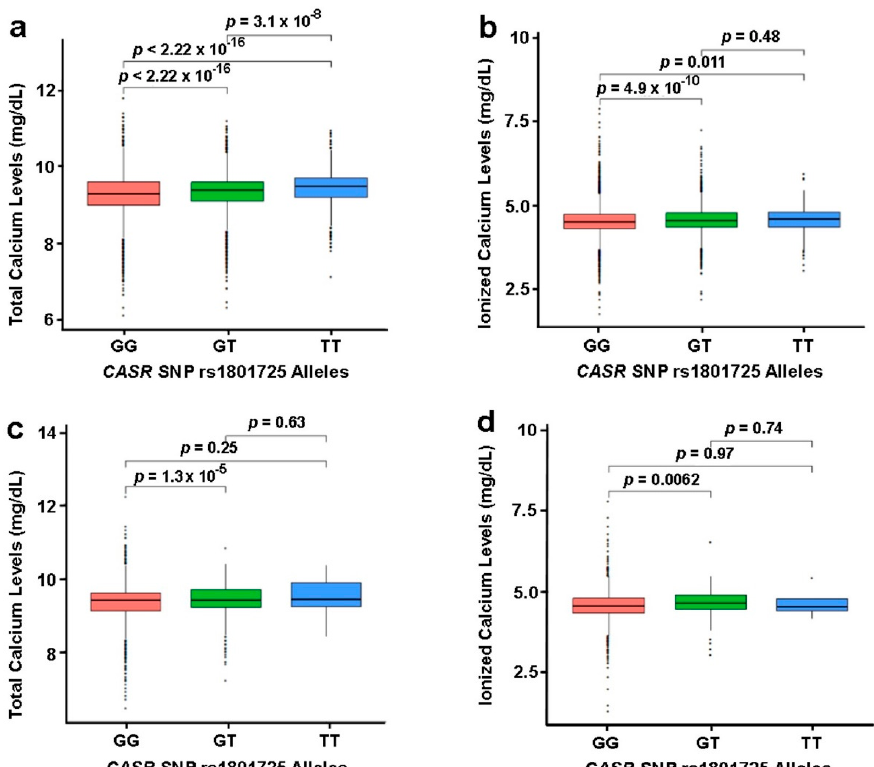
Figure 2. Circulating total calcium and ionized calcium in CaSR rs1801725 allele carriers. Top row ( a , b ): European dataset; bottom row ( c , d ): African dataset. The Wilcoxon rank sum test was used to compare the median circulating total ( a ) and ionized ( b ) calcium levels in individuals of European descent, and total ( c ) and ionized ( d ) calcium levels in individuals of African descent expressing the indicated polymorphisms at rs1801725 depicted by the genotype. p < 0.05 was considered statistically